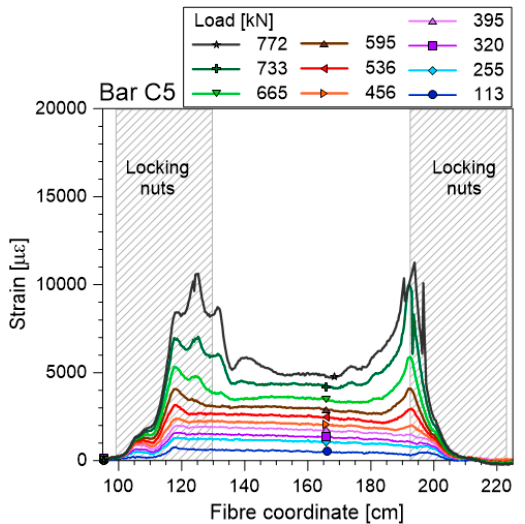
Figure 6. Strain recorded by DFOSs on composite bars (C1–C5) tested in the laboratory.